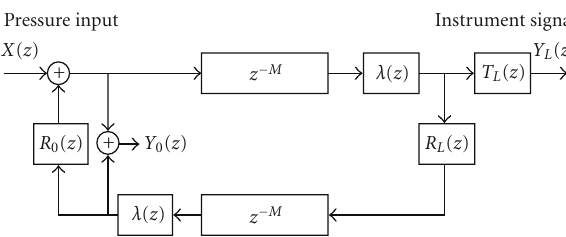
Figure 1: Waveguide model of a cylindrical tube with commuted propagation loss filters λ ( z ) and open-end terminating reflection and transmission filters R L ( z ) and T L ( z ), respectively, and a reflection filter R 0 ( z ) at the (e ff ectively) closed-end termination corresponding to the position of the mouthpiece. Two instrument transfer functions (1) and (2) are developed for observation points yielding Y 0 ( z ) and Y L ( z ), corresponding to the bore base and the instrument output, respectively, in response to input pressure X ( z